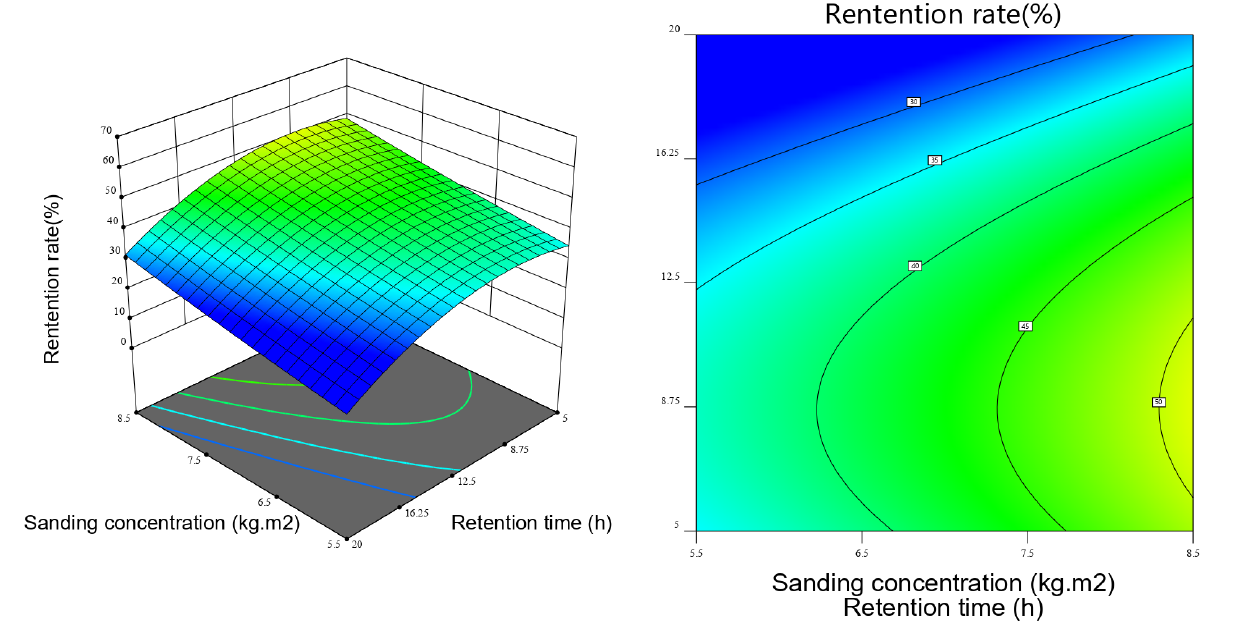
Figure 7. Response surface and contour plots (sand concentration vs. retention time).